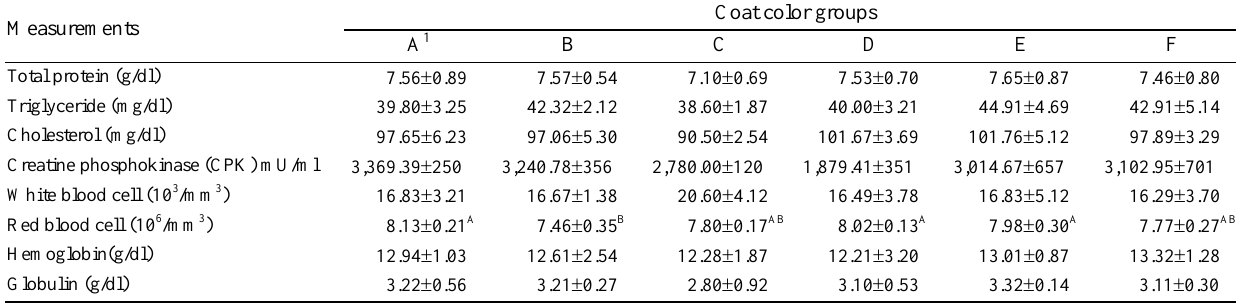
Table 3. Blood characteristics of crossbred pigs (KNP  Landrace) F 2